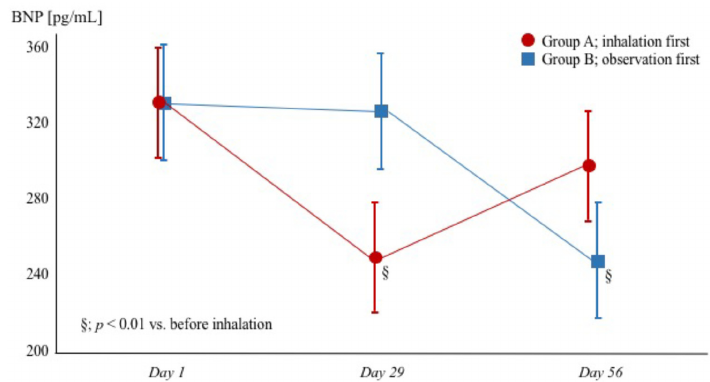
Figure 3. Changes in BNP levels in patients with heart failure with reduced ejection fraction and chronic obstructive pulmonary disease. Red circles ( ● ) and blue squares ( ▪ ) represent group A (tiotropium + observation) and group B (observation + tiotropium), respectively. BNP = brain natriuretic peptide.